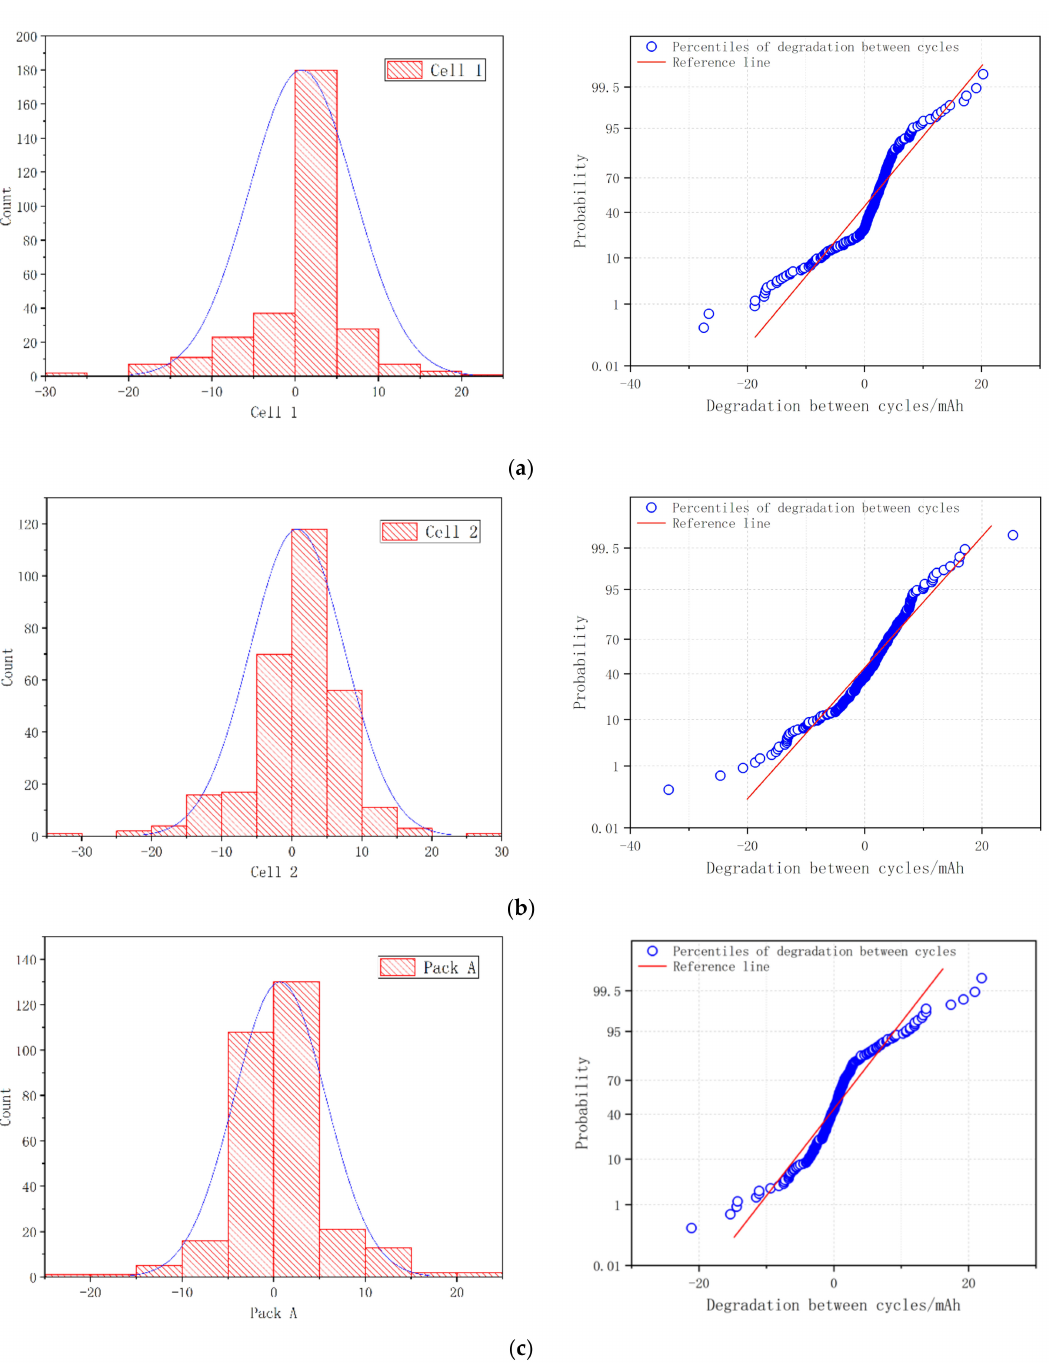
Figure 9. Probability map of the capacity degradation between cycles: ( a ) Cell-1; ( b ) Cell-2; ( c ) Pack A. In order to verify that the amount of degradation between cycles followed a normal distribution, the cell and the battery were tested for normality. Table 6 shows the means and variances of the normal distribution of the three configurations, as well as the p -values of the normal test. It was generally considered that if the p -value was greater than 0.05, the data were considered to be from a normal